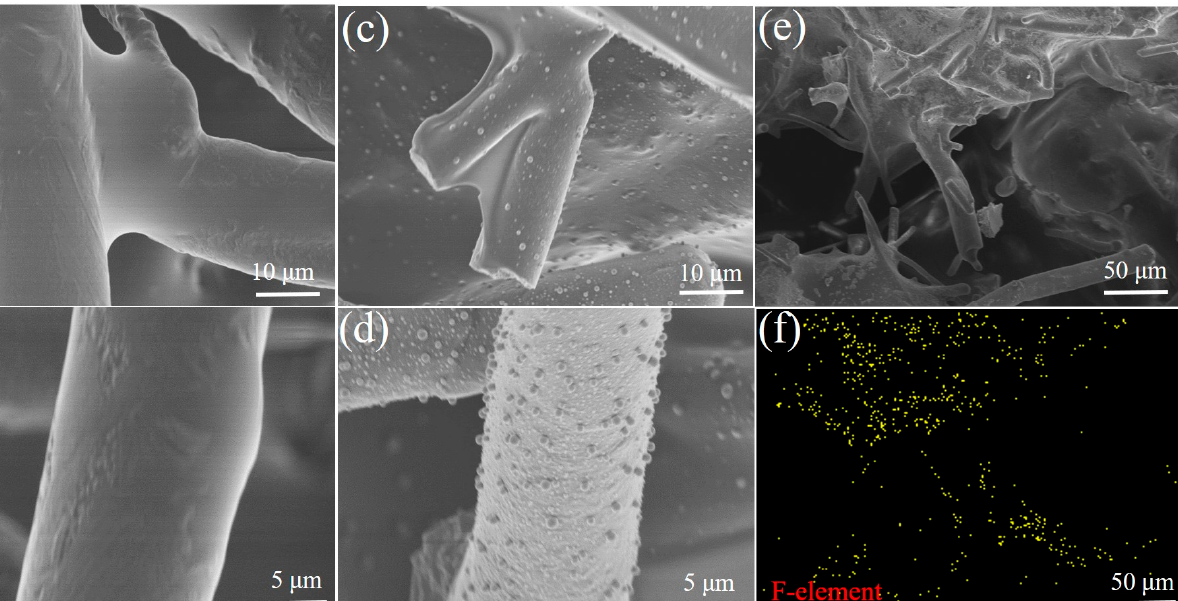
Figure 3. Water contact angle of ceramic membranes: ( a ) unmodi fi ed ceramic membrane; ( b ) PDMS- ceramic membrane; and ( c ) PTFE-ceramic membrane.